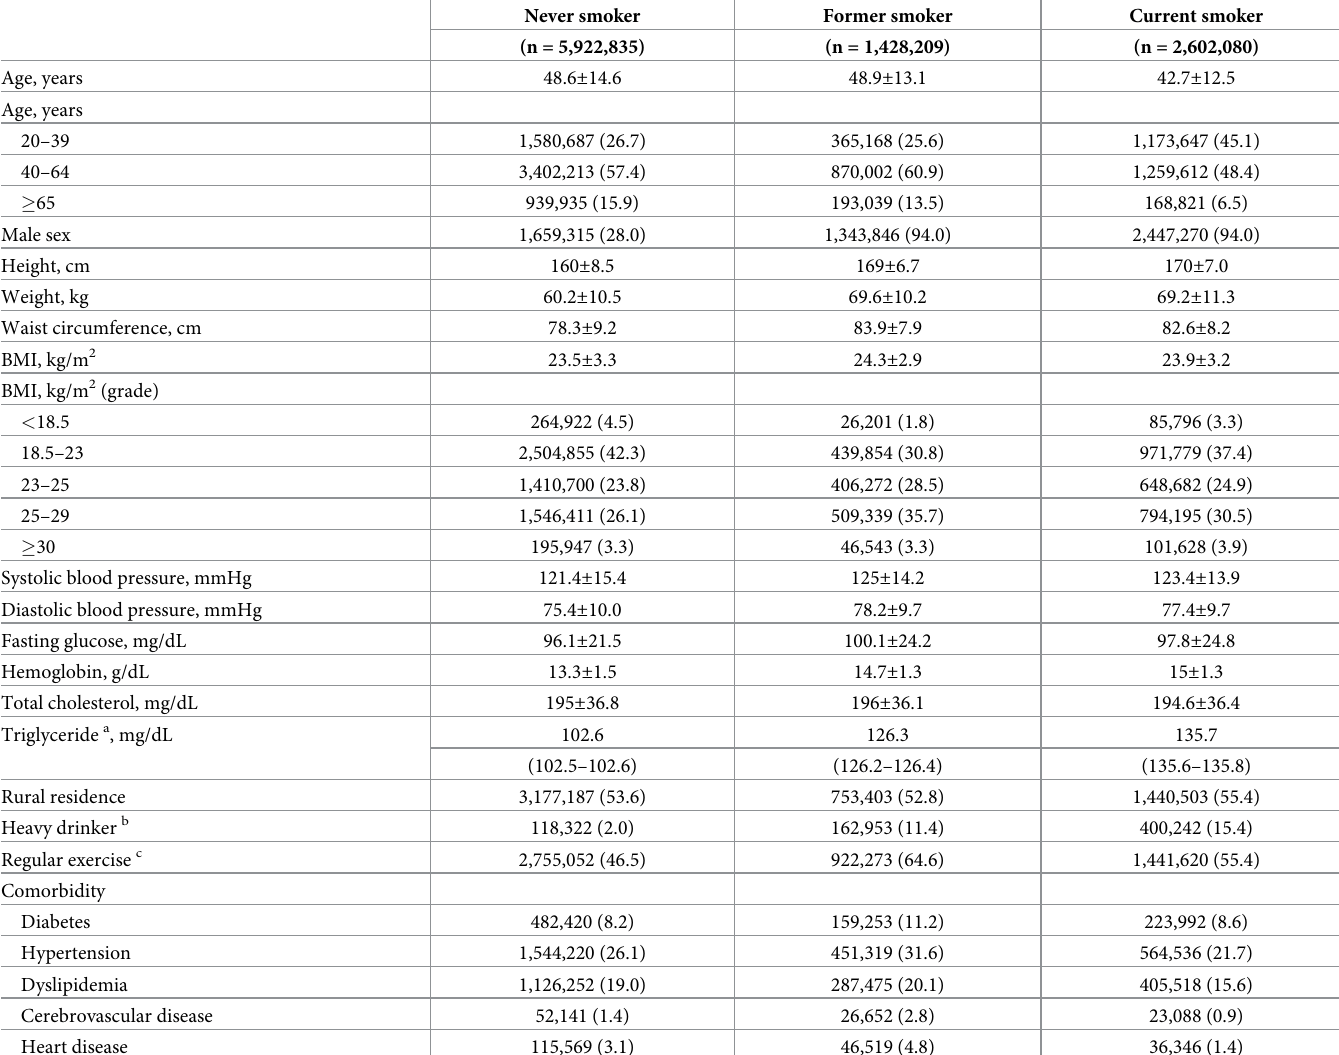
Table 1. Baseline characteristics of the study